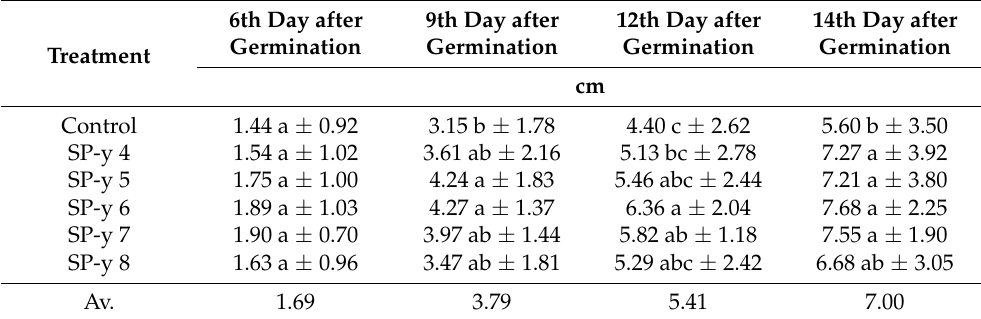
Table 4. Mean comparison of effects of six concentration levels of S. yanoikuyae SJTF8 on rice shoot lengths from 6 to 14 days after